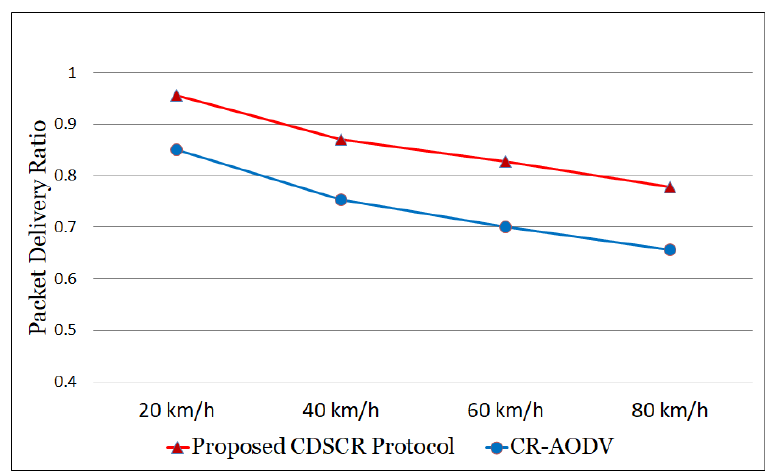
Figure 13. Packet delivery ratio versus node mobility.